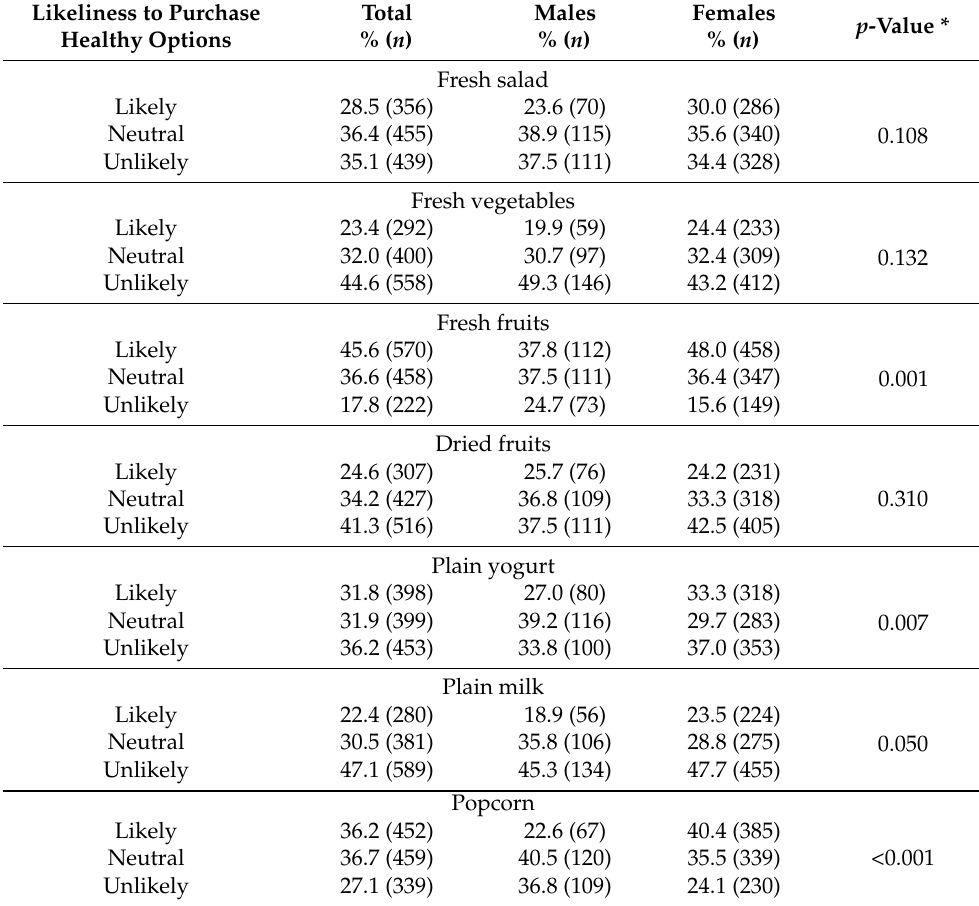
Table 4. Likeliness to purchase healthy options from the vending machine among the study partici- pants ( n =